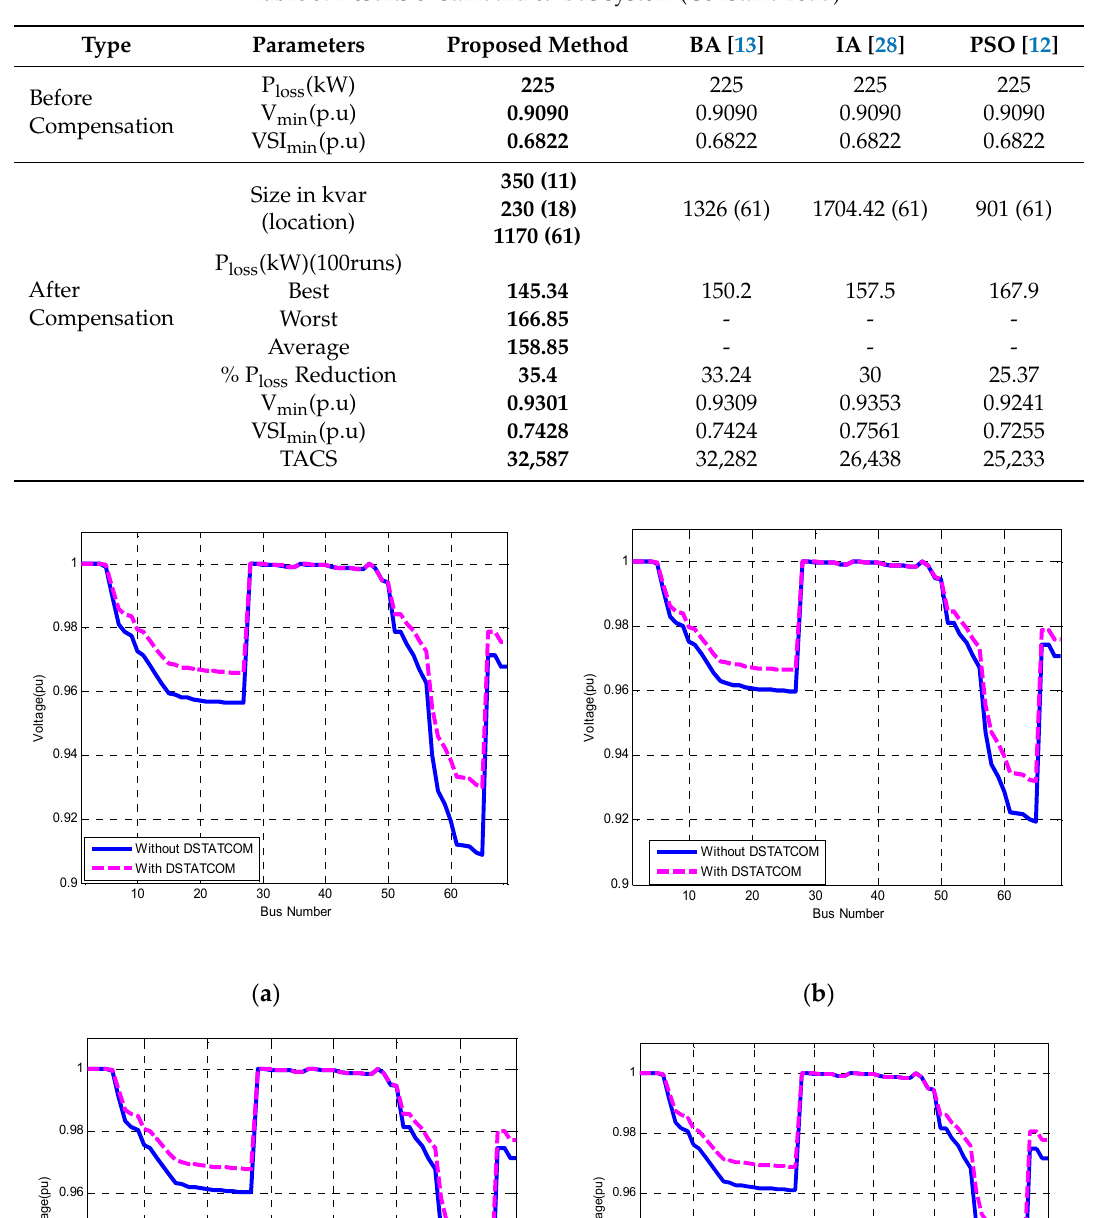
Table 5. Results of standard 69-bus system (Constant Load). Table 6. Results of standard 69-bus system with different Load Models.